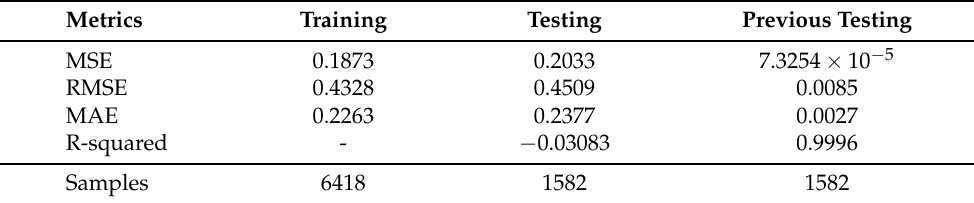
Table 7. Performance results of the supercapacitor with just the Volt input for Dataset A.